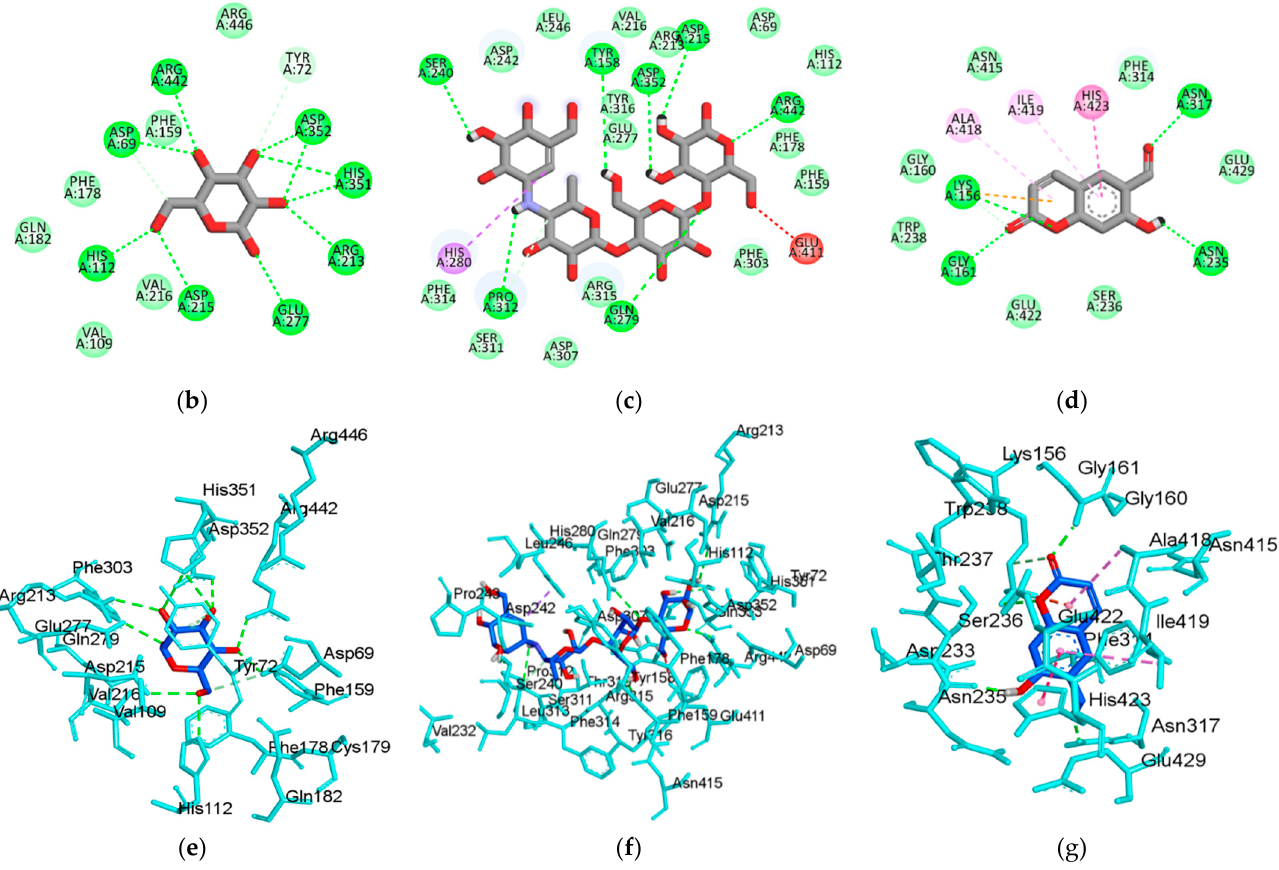
Figure 3. Molecular docking model for α -glucosidase inhibition by 6-formyl umbelliferone (6-FU). ( a ) Overlapping of the docked acarbose (dark pink), alpha D-glucose (yellow), and 6-FU (blue) within the active site of α -glucosidase (PDB: 3A4A). 2D interactions of alpha D-glucose ( b ), acarbose ( c ), and 6-FU ( d ) inside the active pocket of α -glucosidase. Molecular docking model for α -glucosidase inhibition by 6-FU and diagrams of 3D ligand interactions and major binding interactions between the inhibitors and the active site of 3A4A: alpha D-glucose ( e ), acarbose ( f ), and 6-FU ( g ). The interactions are represented in green (conventional hydrogen bonding), pink ( π -alkyl interactions), gold accent ( π -cation), purple ( π -sigma), dark pink ( π - π T shaped), red (donor-donor acceptor), and light green (carbon hydrogen bond).